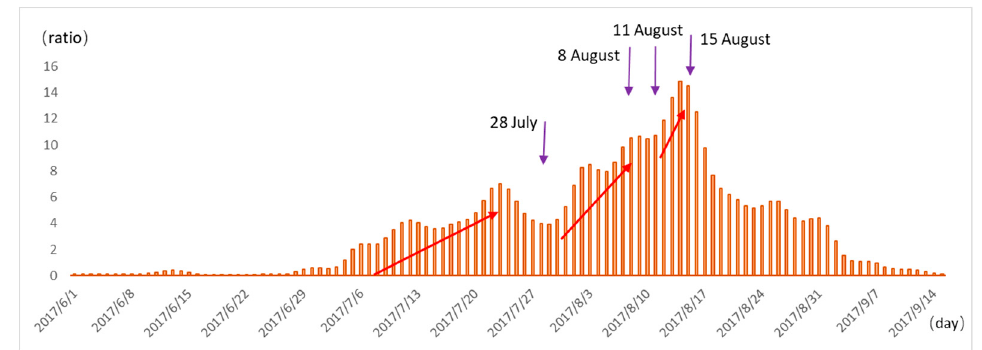
Figure 9. Increasing trends of thermal radiation (mean power spectrum of temperature of brightness blackbody (TBB), outgoing longwave radiation (OLR), and medium-wave infrared brightness (MIB)) and total electron content (TEC). Red arrows denote phases of increasing thermal radiation; purple arrows denote TEC disturbances.